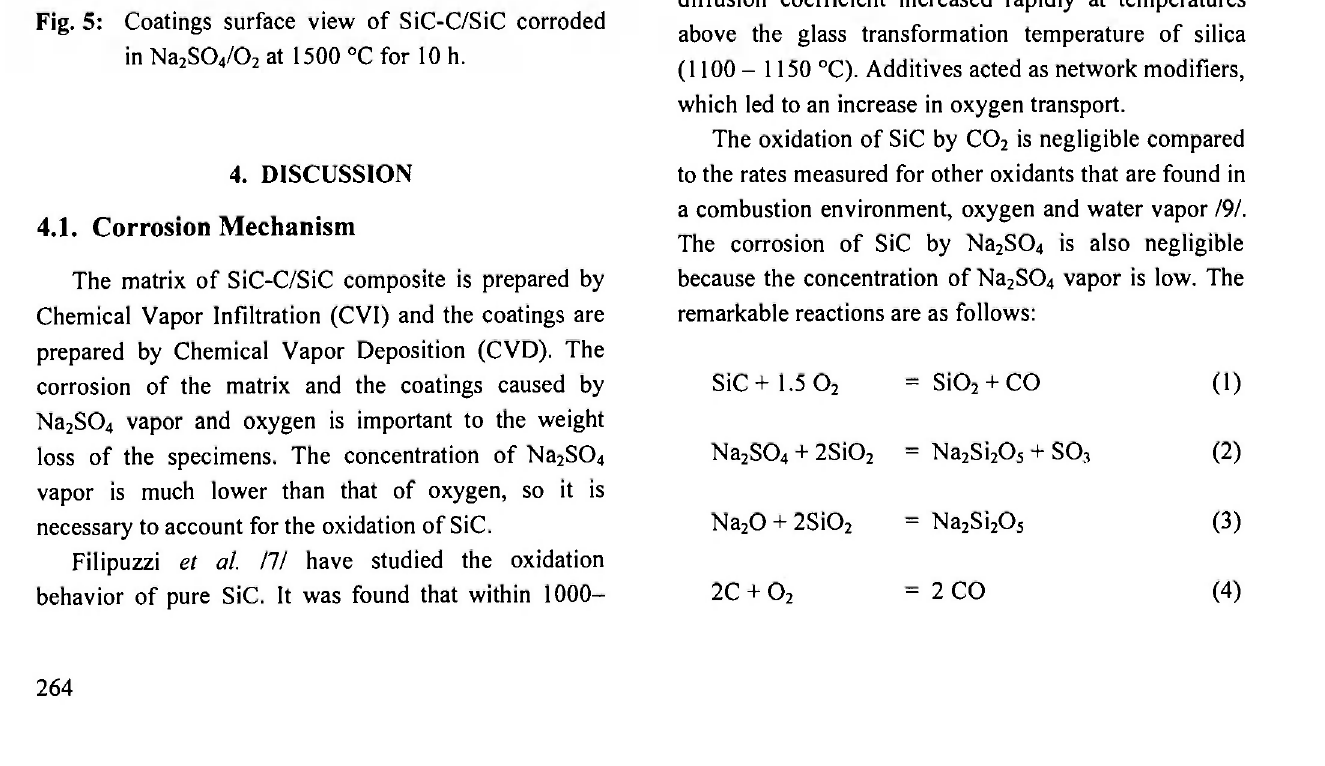
Fig. 5: Coatings surface view of SiC-C/SiC corroded in Na 2 S0 4 /0 2 at 1500 °C for 10